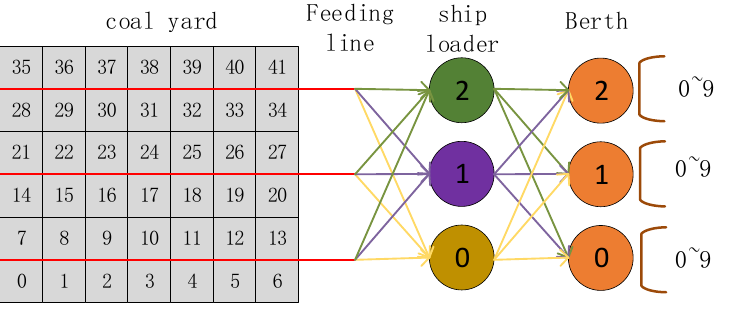
Figure 3. MDP modeling of port scheduling.